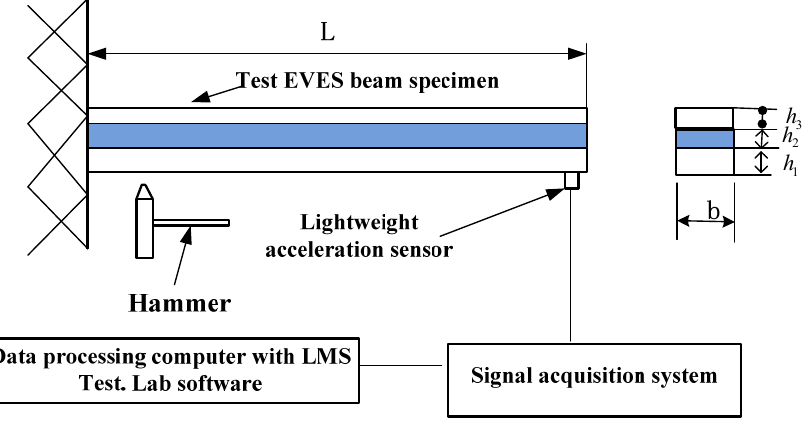
Figure 4. Experimental setup.